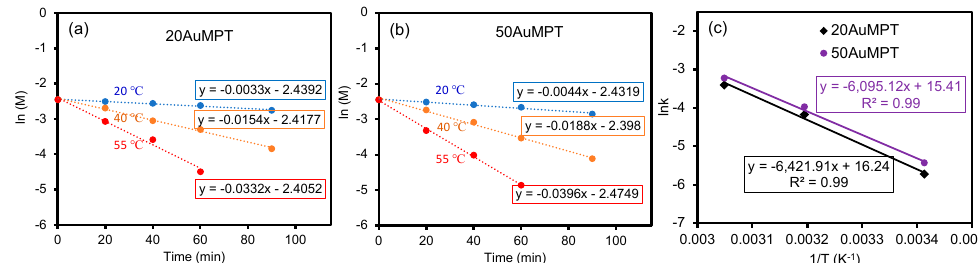
Figure 6. Reaction kinetics of ( a ) 20AuMPT (20 wt% AuNPs onto mesoprousTiO 2 particles) and ( b ) 50AuMPT (50 wt% AuNPs onto mesoprousTiO 2 particles), as well as ( c ) Arrhenius plots obtained from the absolute temperature (1/T) and the logarithm of reaction rates (lnk) to estimate the E a values for the homocoupling of phenylboronic acid. All straight lines were drawn based on the best fit.